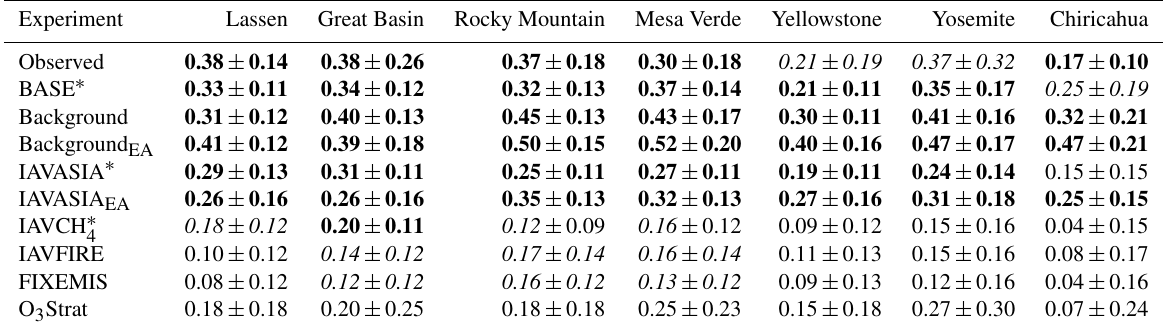
The ∗ mask indicates data filtered to represent baseline conditions (NACOt ≤ 67th). The EA subscript indicates that data were filtered to represent transport conditions favoring the import of Asian pollution (EACOt ≥